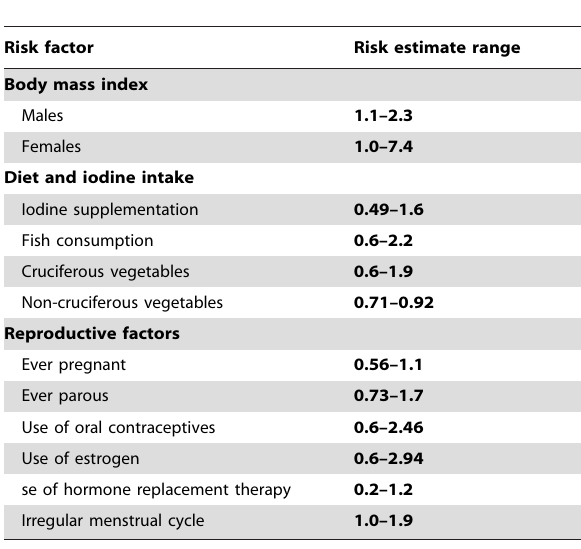
Table 1. Range of risk estimates for thyroid cancer for selected risk factors.